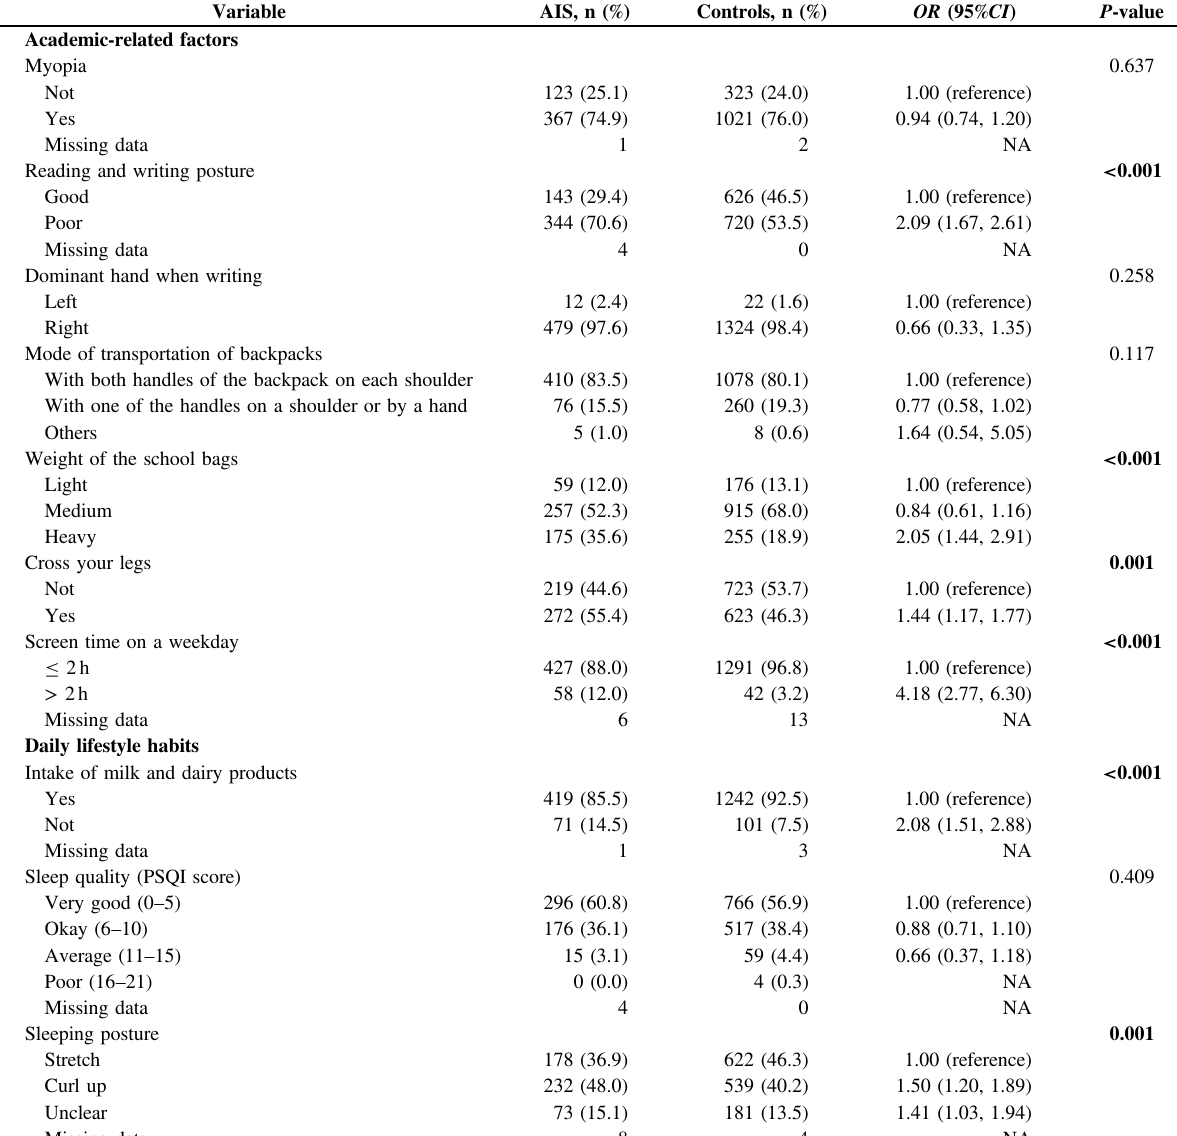
Table 2 Associations between academic-related factors and daily lifestyle habits and